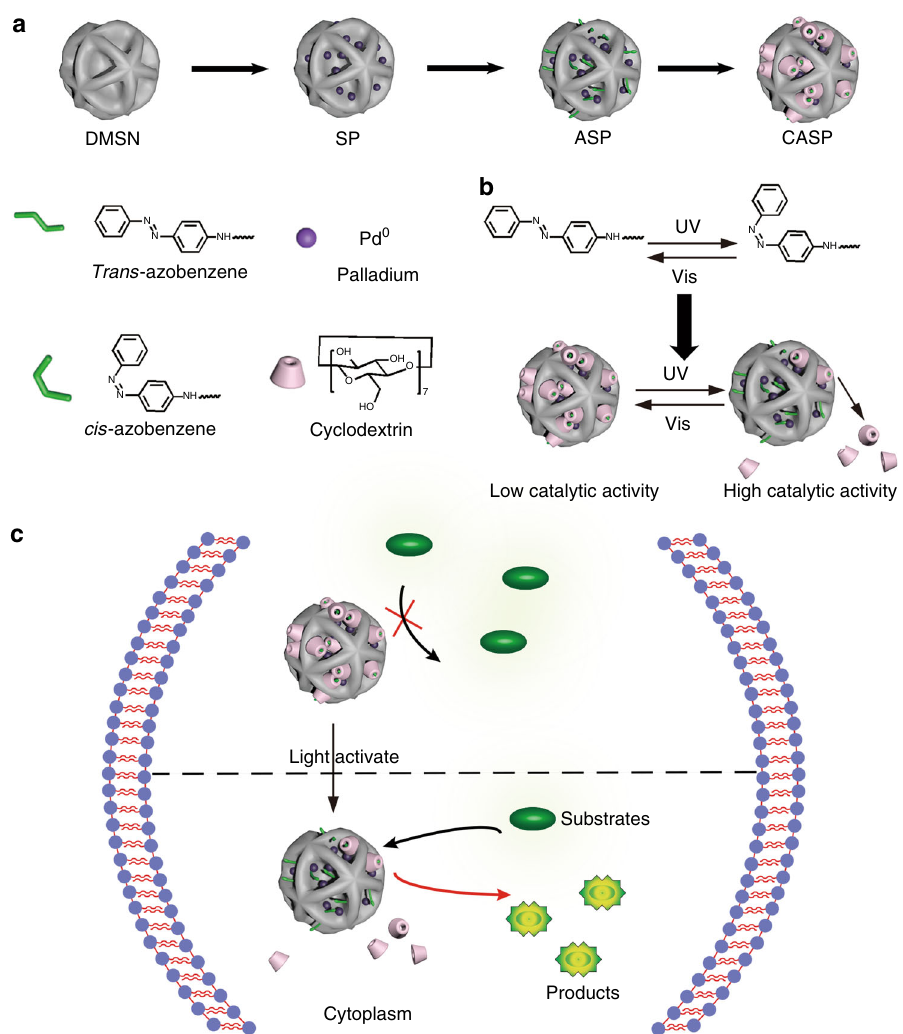
Fig. 1 Illustration of design of photo-responsive bioorthogonal catalysts in cells. a Macroporous silica (DMSN), Pd-embedded silica nanoparticles (SP), Azo-modi fi ed complex catalyst (ASP), and CD-capped complex catalyst (CASP) used in the study. b The photo-isomerization process between trans - azobenzene and cis -azobenzene can cause the dissociation and recombination of CD. c Intracellular bioorthogonal catalysis with